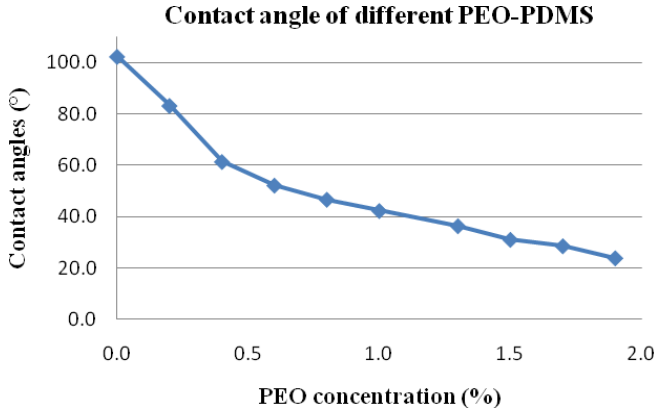
Figure 11. Static water contact angles of the PEO-PDMS (PEO concentration is 0.2%–1.9% to the PDMS base polymer).